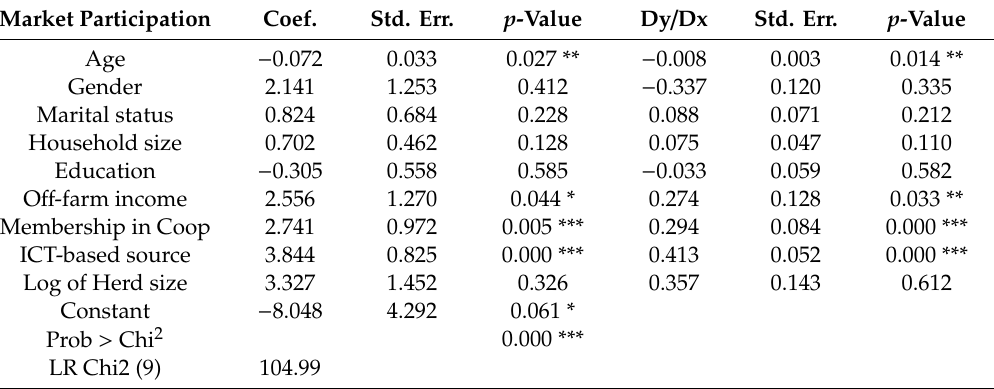
Table 4. E ff ect of variables including ICT-based information source on market participation. Market